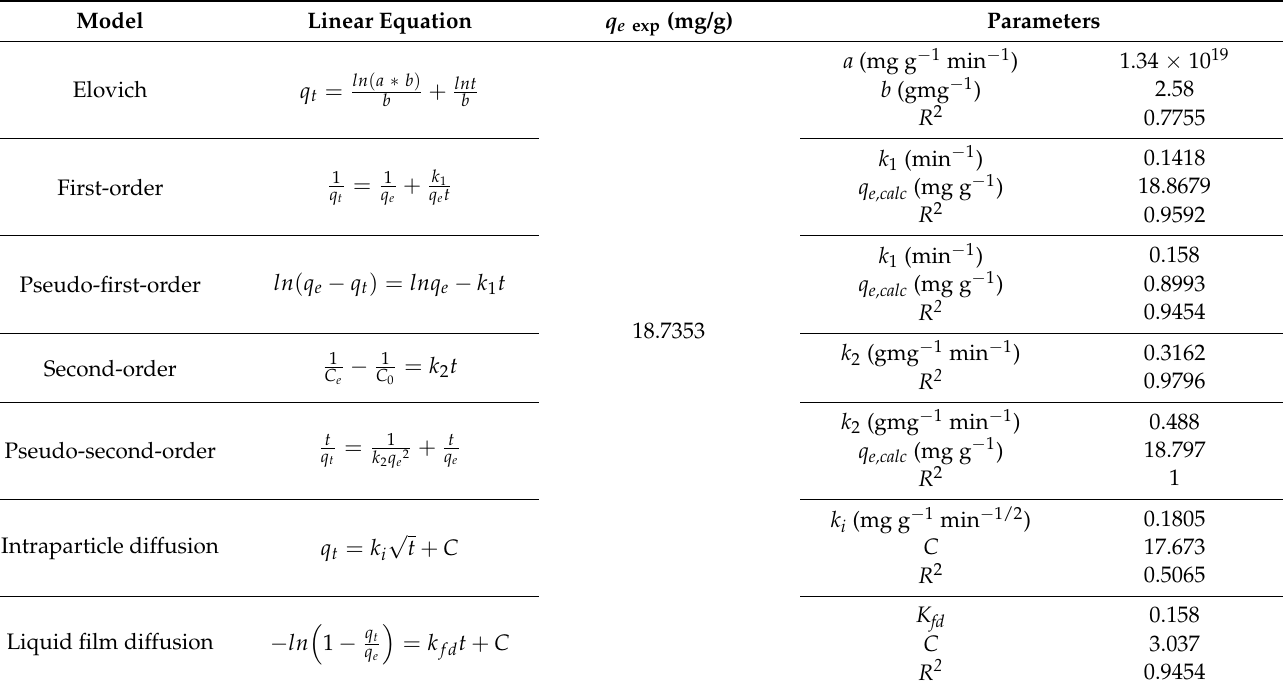
Table 4. Kinetic parameters for the sorption of MB onto